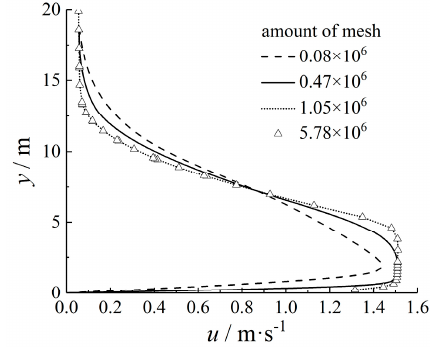
Figure 3. Velocity profile in different mesh resolution.